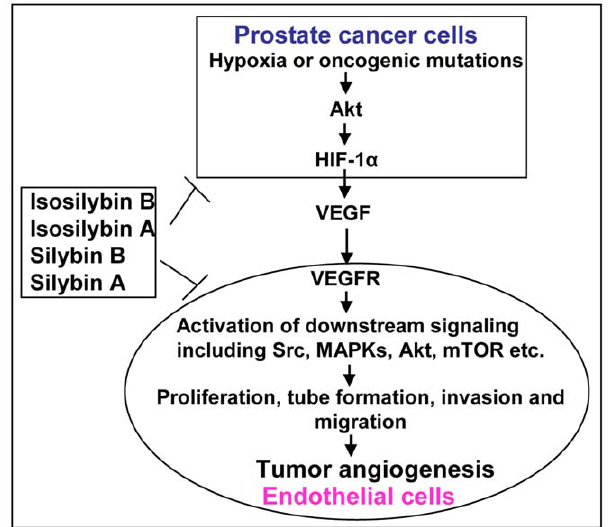
Figure 10. Diastereoisomers exhibit anti-angiogenic effects through targeting signaling molecules in both prostate cancer cells and endothelial cells. Silybin A, silybin B, isosilybin A and isosilybin B target angiogenesis in prostate tumors through targeting signaling molecules in PCA cells as well as in endothelial cells, the important component of PCA